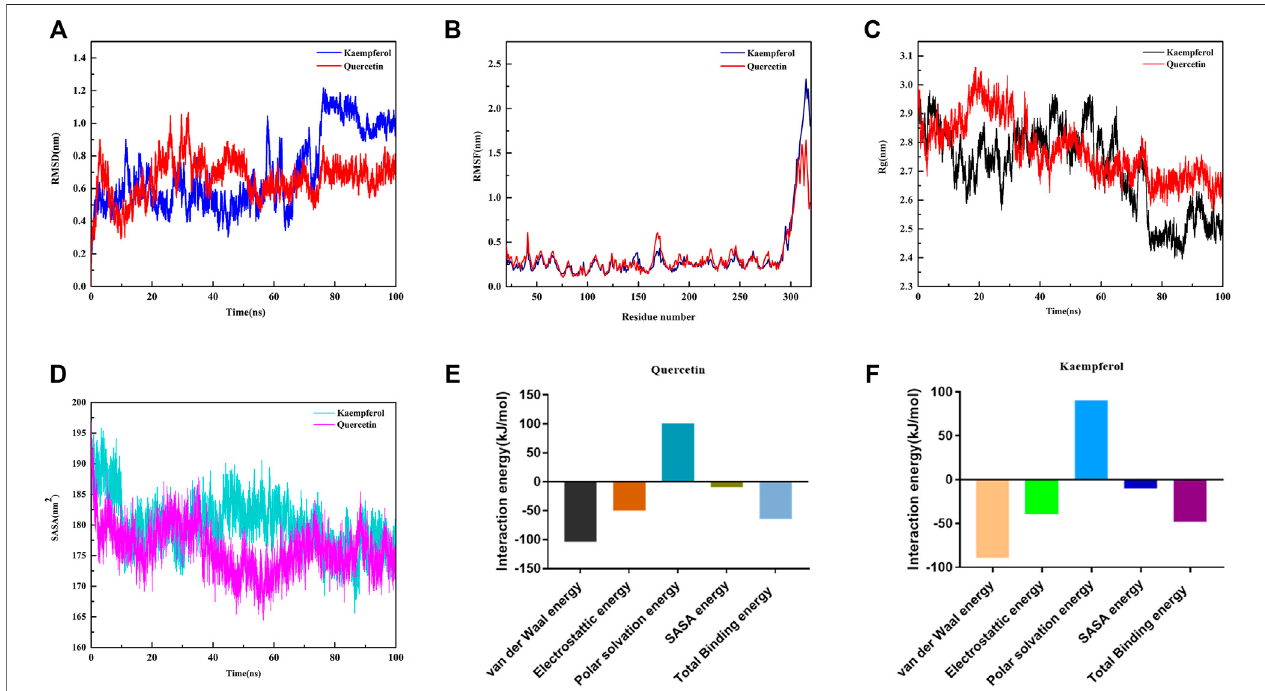
FIGURE 6 | Pro fi les of molecular dynamics simulations. (A) RMSD analysis for the protein-ligand complexes. (B) RMSF analysis for the protein-ligand complexes. (C) Plot of Rg varies with time. (D) Plot of SASA of complexes. (E) Binding free energy decomposition of quercetin-NF- κ B p65 complex. (F) Binding free energy decomposition of kaempferol-NF- κ B p65